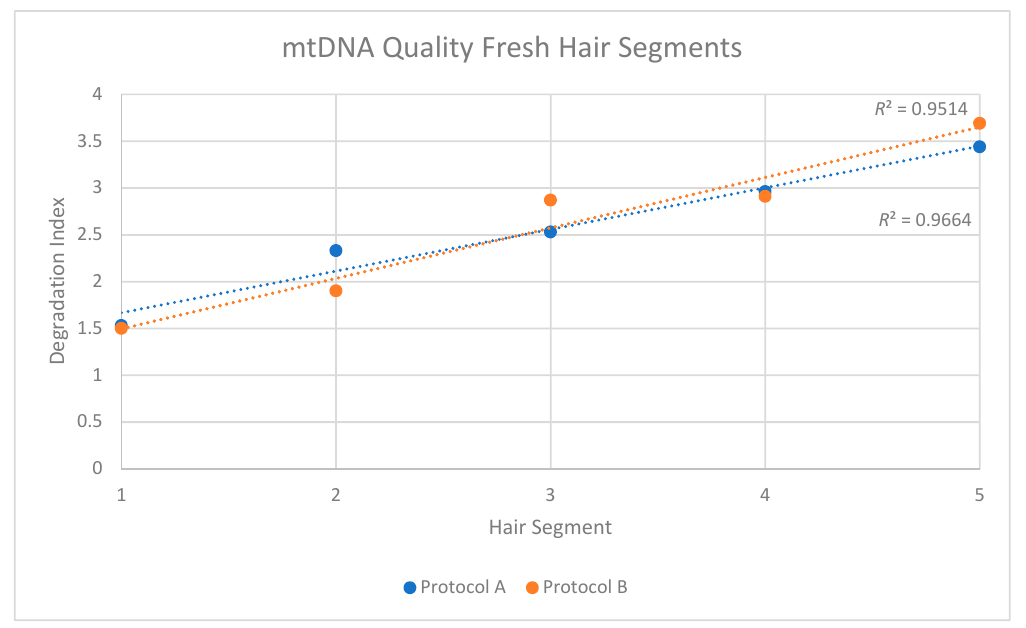
Figure 3. Mitochondrial DNA quality in five segments of recently collected hair. Two replicates (orange series and blue series) were performed for each segment.